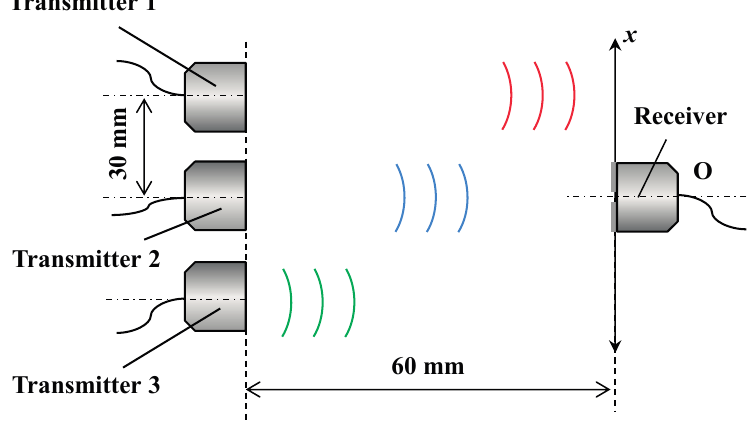
Figure 4. Experimental setup for measuring lateral displacement over a wide